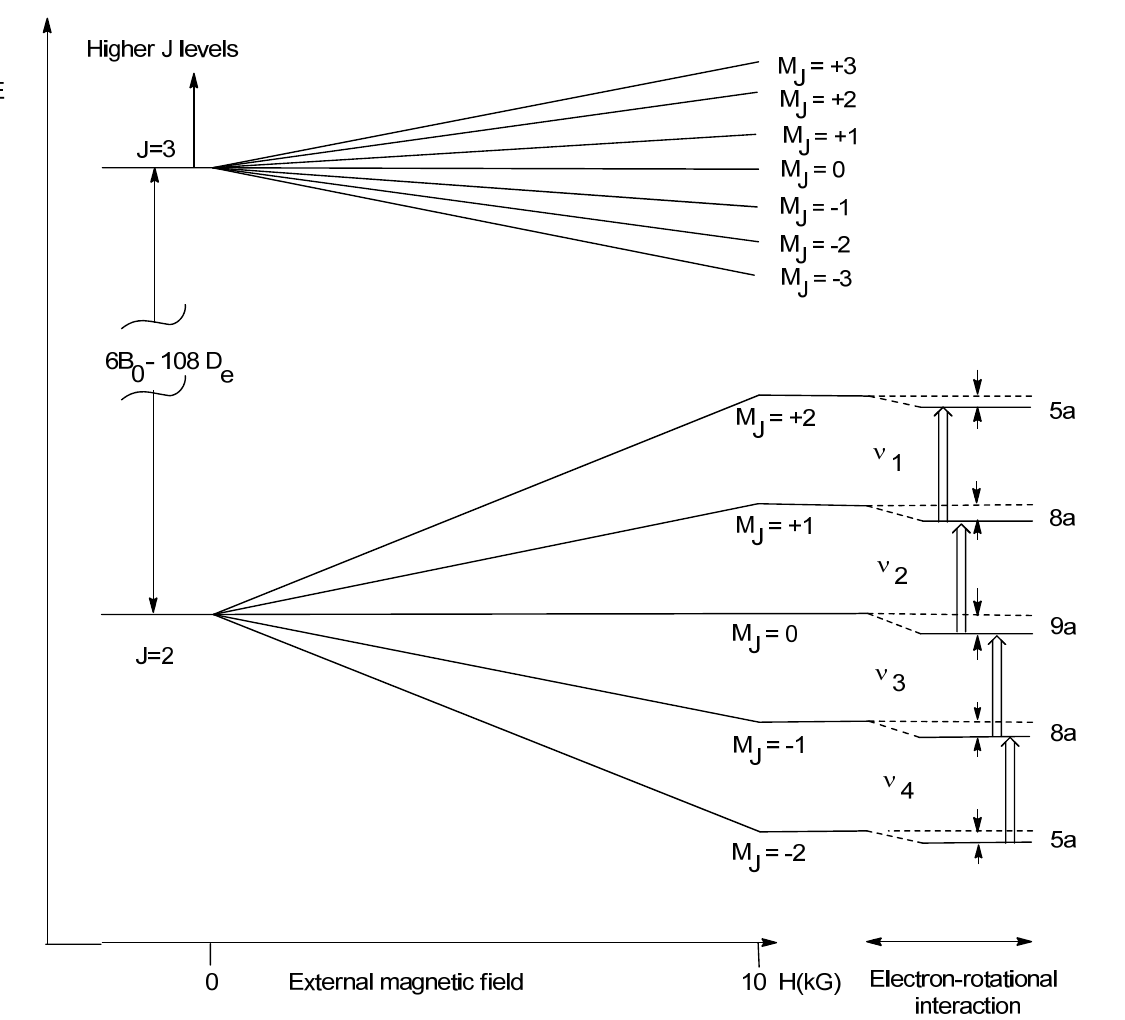
Figure 2. Splitting of the ground and first excited rotational levels of the singlet oxygen 1 O 2 ( 1 Δ g ) state in magnetic field H .